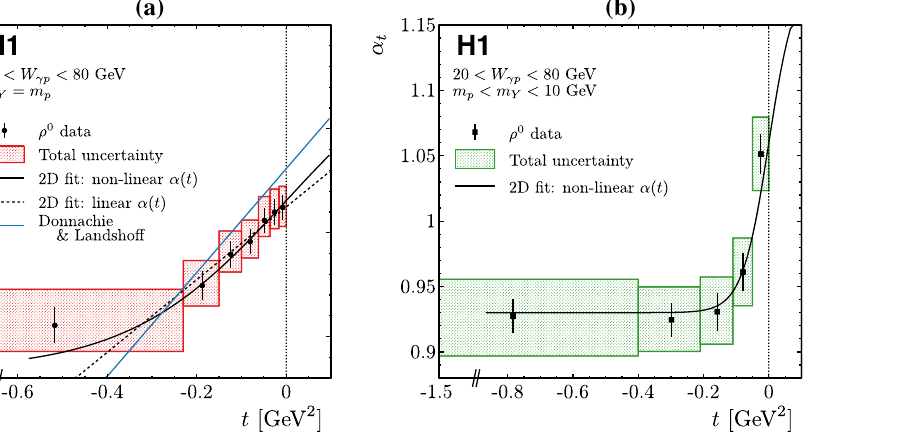
Fig. 19 Fit parameters α t as functions of t for the elastic ( m Y = m p ) ( a ) and proton-dissociative ( m p < m Y < 10 GeV) ( b ) differential ρ 0 meson photoproduction cross sections d σ(γ p → ρ 0 Y )/ d t ( t ; W γ p ) . The parameters are obtained from fits of a power law to the energy dependencies of the cross sections in all t bins, as described in the text.